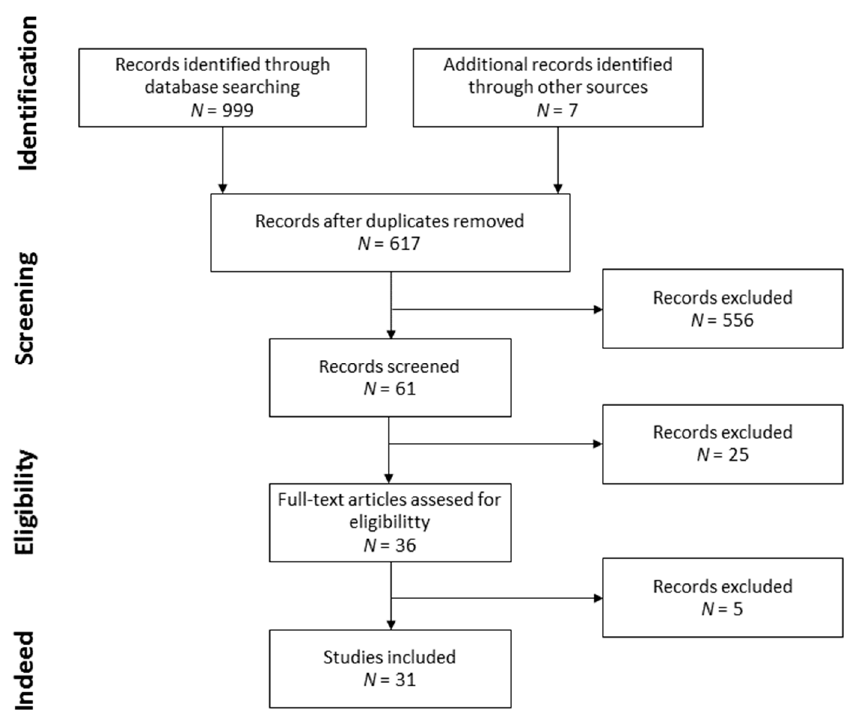
Figure 1. Flow diagram of record selection.